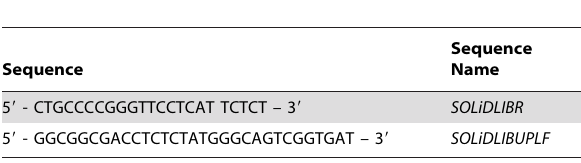
Table 2. Oligonucleotide sequences used, in conjunction with the Universal Probe Library # 149 (Roche), for qPCR of the SOLiD sequencing